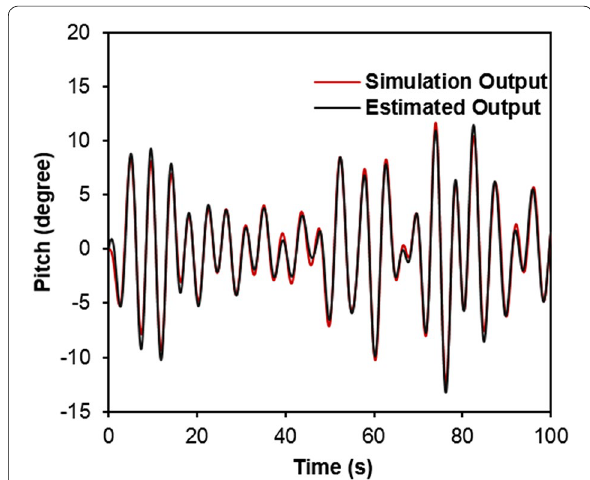
Fig. 13 Simulation output and estimated output of the system. Estimated output of the identified model fits the output of the simulation by 82.4% in response to a multi-sine input